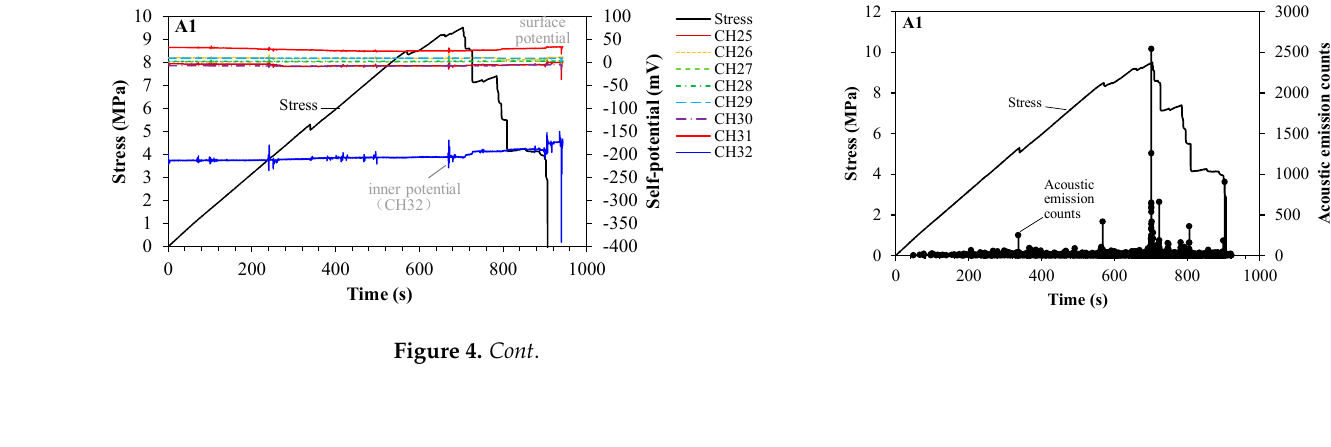
elastic deformation stage showed marked fluctuations compared with samples B1 to B6. A1 and A2; 0.002 mm/s for samples A3, A4 and A6; and 0.005 mm/s for sample A5. The loading rates for the B-samples were 0.001 mm/s for sample B1; 0.005 mm/s for samples B2, B3 and B4; and 0.002 mm/s for samples B5 and B6. The different loading rates had a weak influence on the amplitude of the self-potential variation.